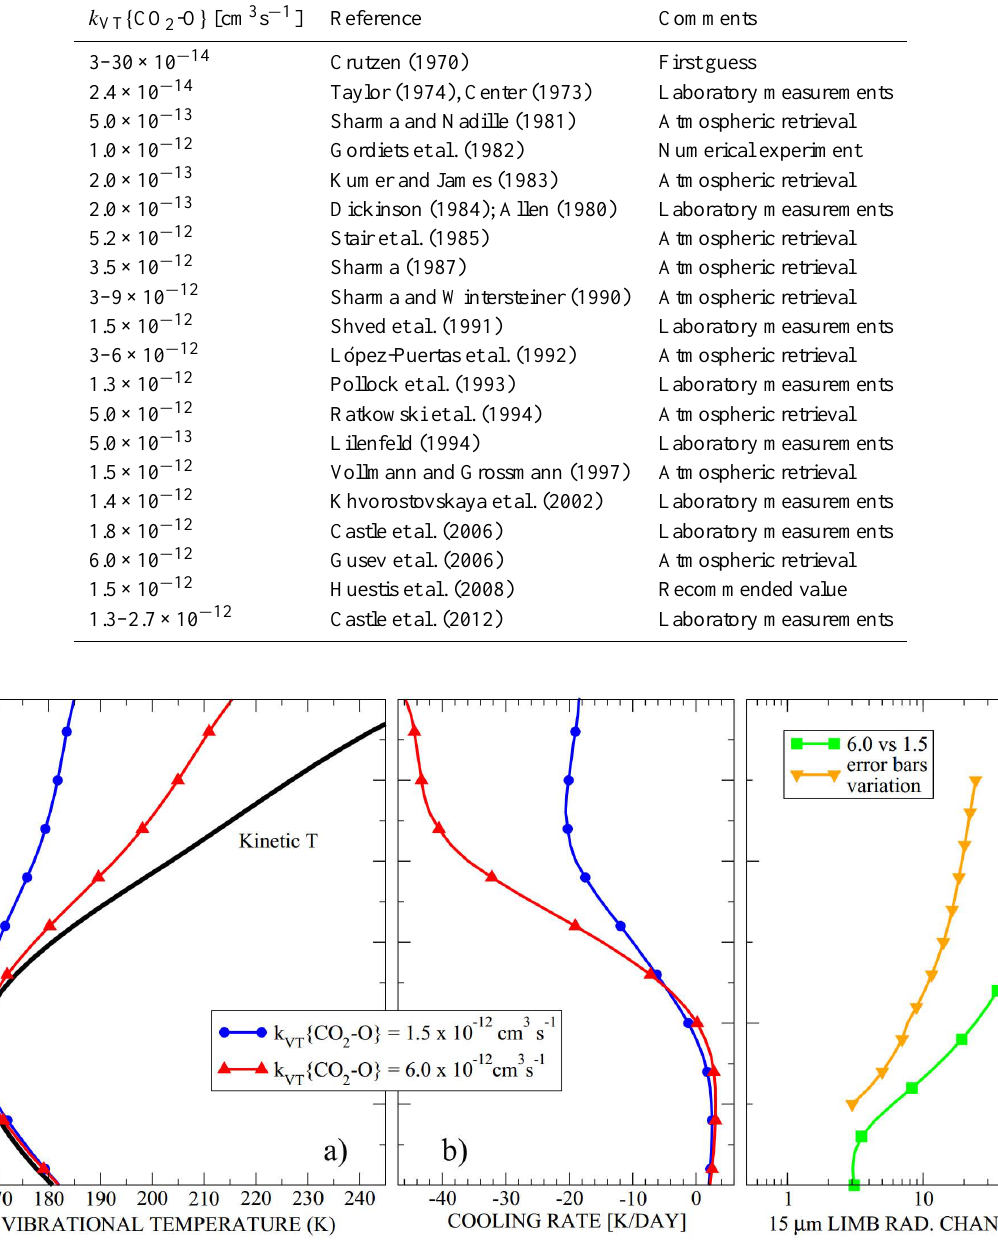
Fig. 1. The sensitivity of (a) CO 2 (010) main isotope vibrational level populations, (b) infrared cooling/heating rate in CO 2 bands, and (c) I 15 µ m (z) to k VT . For panels (a) and (b) : lines with circles correspond to k VT = 1 . 5×10 − 12 cm 3 s − 1 and lines with triangles corre- spond to k VT = 6 . 0×10 − 12 cm 3 s − 1 . The non-LTE populations in panel (a) are presented as vibrational temperatures, which represent the vibrational level excitation against the ground level 0: n 1 /n 0 = g 1 /g 0 exp[ − ( E 1 − E 0 )/kT v ], where n 0 , 1 , g 0 , 1 , and E 0 , 1 are populations, degenerations, and energies of the ground state and first vibrational level, respectively. The atmospheric model used for this sensitivity study is the midlatitude summer profile of temperature, pressure, and atomic oxygen VMR from the MSIS-E-90 combined with the WACCM CO 2 VMR profile for the corresponding conditions. The curves with squares/triangles in panel (c) show the I 15 µ m (z) responses for the cases when the k VT changes from 1.5 to 6.0×10 − 12 cm 3 s − 1 and varies within estimated uncertainties in Fig. 2c, correspondingly (see also the discussion in Sect.